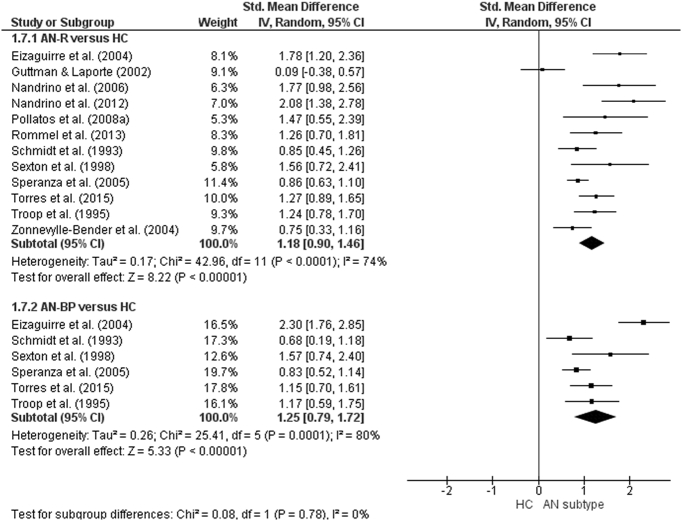
Forest plot of mean TAS score: standardized mean effect size for differences (SMD) between Anorexia Nervosa, Restricting subtype (AN-R) and Healthy Controls (HC) and between Anorexia Nervosa, Binge-Purge subtype (AN-BP) and HCs. CI, confidence interval.